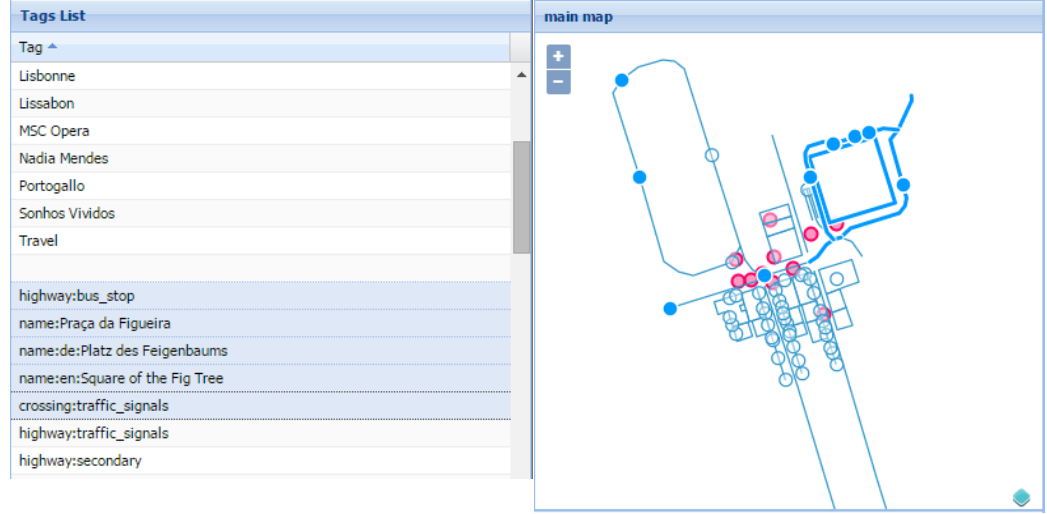
Figure 8. Selecting features by tag with multiple tags selected (note: the light blue features depict OSM features, the red features represent Panoramio photos, and the highlighted blue features symbolize features that have been selected).